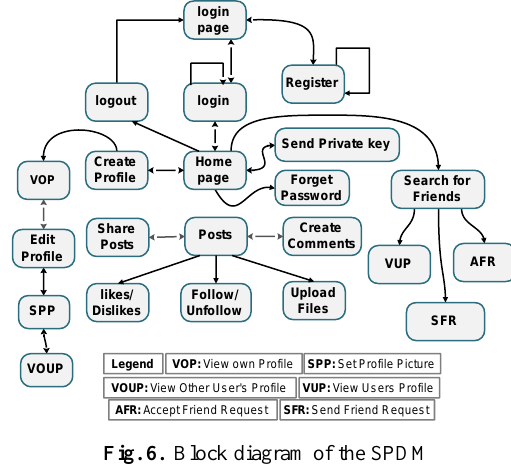
Fig. 6. Block diagram of the